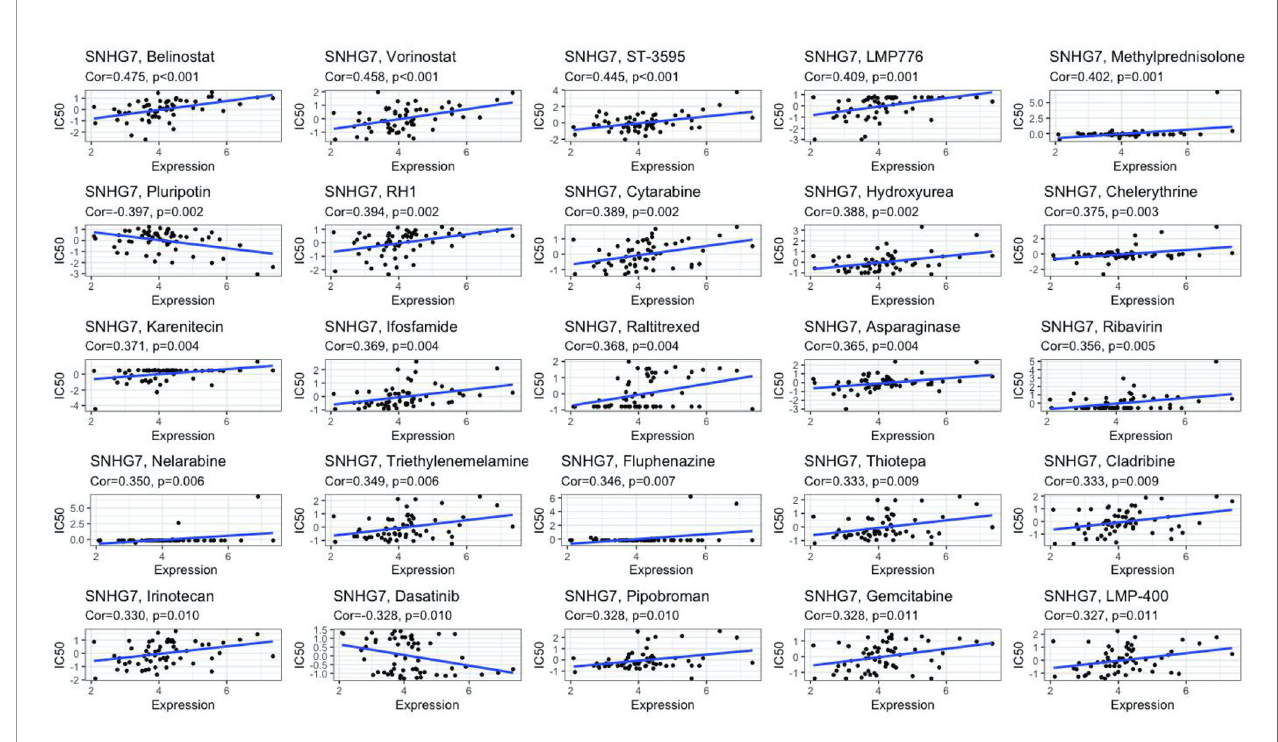
FIGURE 7 | Drug sensitivity analysis of SNHG7.